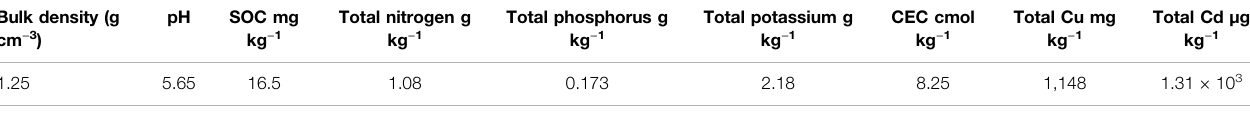
TABLE 1 | Soil characteristics in the study site prior to this study (SOC (cid:2) soil organic carbon). Bulk density (g cm − 3 )